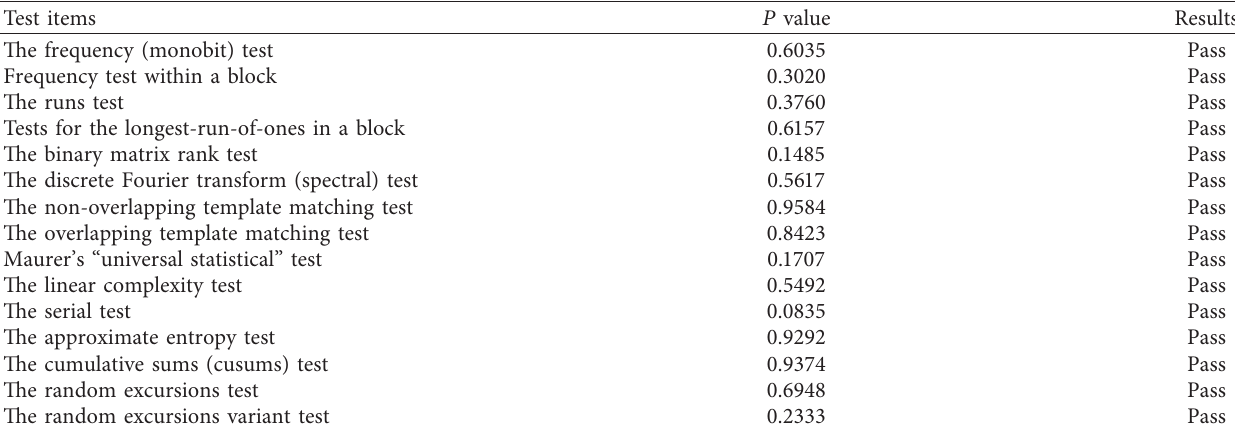
Table 13: Randomness of the encrypted image